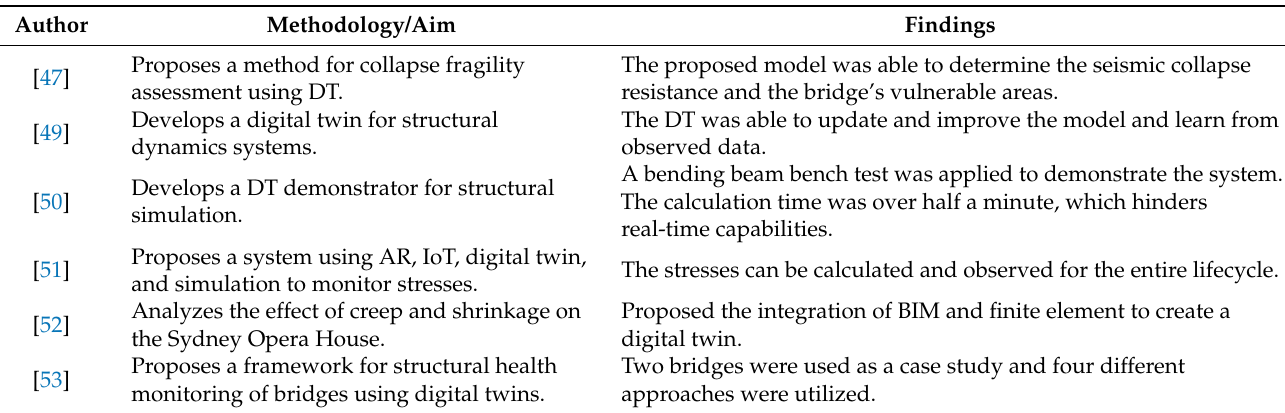
Table 4. Digital Twin for Structural Health